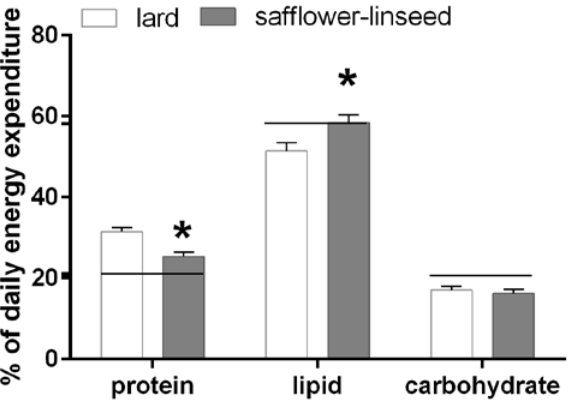
Figure 2. Percent contribution of lipids, proteins and carbohydrates to total daily energy expenditure (lard = 380 ± 15, safflower-linseed = 410 ± 25 kJ/day × kg 0.75 ) in rats fed lard or safflower-linseed high fat diet. Values are reported as means with their standard errors. n = 8 different rats. * p < 0.05 compared to lard. Horizontal lines indicate the percent of each macronutrient in the diet (carbohydrate = 20.7%, protein = 21.1%, lipid = 58.2%).